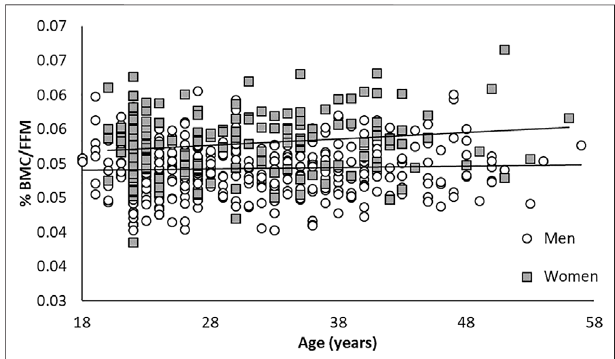
FIGURE 2 | Relationship between %BMC/FFM across age for men and